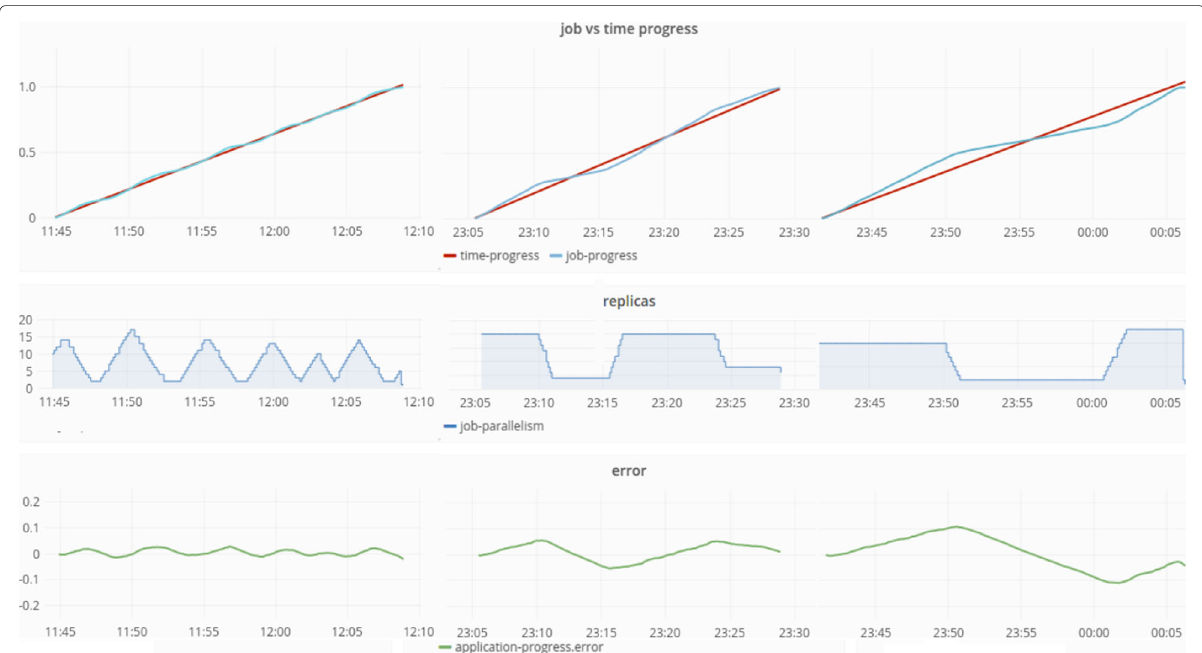
Fig. 11 Selected executions in the Grafana dashboard with tolerances set to 0%, 5%, and 10%